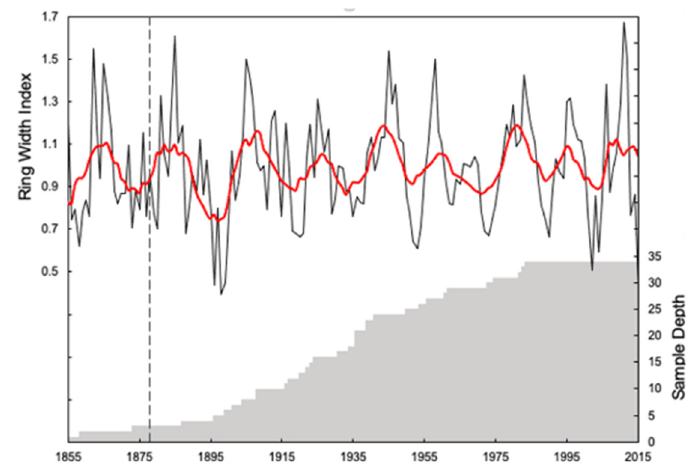
Figure 3. Tree ring chronology for the Crestline ponderosa pine. A 10-year running mean is plotted in red and the number of tree samples used is shaded in gray. The point at which the chronology exceeds an expressed population (EPS) threshold of 0.85 is given by the dashed line. Table 2. Correlation coefficients between the tree ring chronology and monthly, seasonal, and annual climate trends and selected climate indices at Crestline, CA. Values in bold represent statistically significant correlations at the 95% confidence level (p < 0.05) or higher.